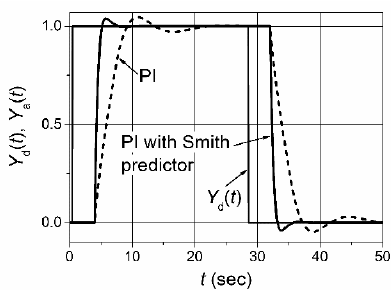
Figure 3. The set-point pulse-response of the control system based on the PI controller and the PI controller with the Smith predictor. The plant-transfer function including the delay term is G p (s) e − Tp s = [1/(s + 1)] e −3.5 s . The parameters of the PI controller are K p = 0.37, K i = 0.18; the parameters of the PI controller used with Smith predictor are K p = 2, K i = 3; the transfer-function of the plant model in the Smith predictor is G m (s)= 1/(s + 1); the transport delay used in the model is T m = 3.5 s.